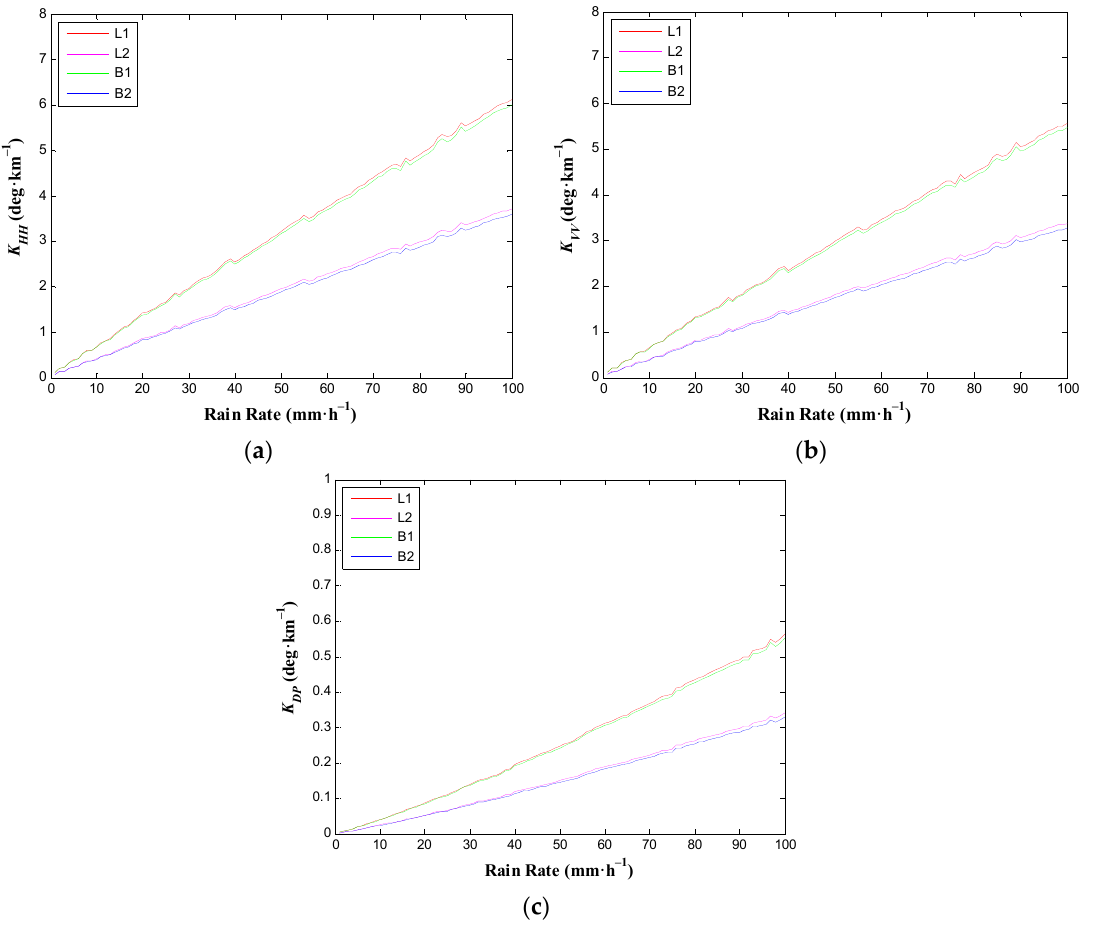
Figure 3. Polarimetric propagation parameters vs. rain rate for frequencies of GPS and BeiDou signals. ( a ) K HH - R ; ( b ) K VV - R ; ( c ) K DP - R .